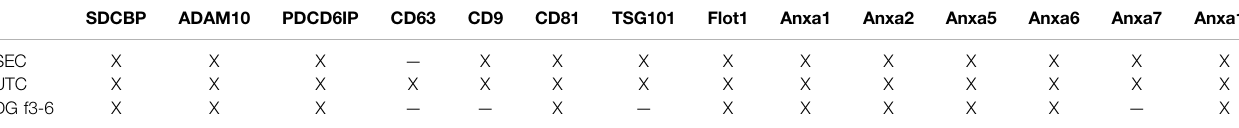
TABLE 1 | EV markers identi fi ed by SEC, UTC, and DG f3-6.